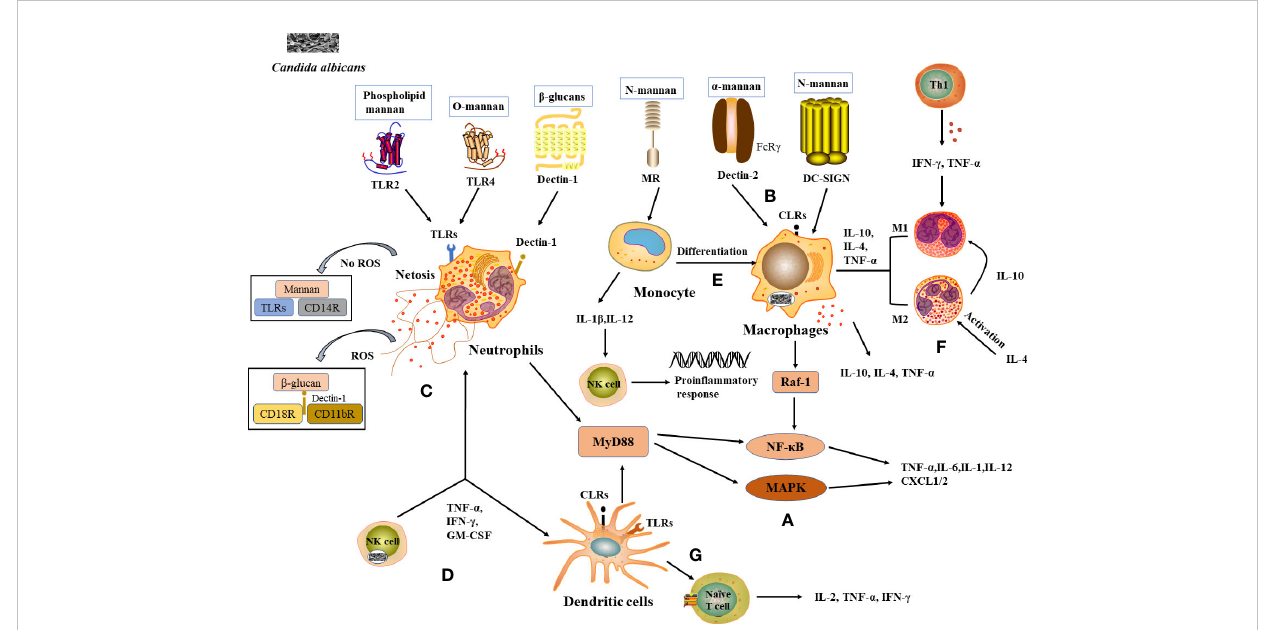
FIGURE 1 Recognition of C albicans cell wall components with PRRs and induction of immunocellular response. (A) TLRs and CLRs recognize with C albicans and activate immune cells to produce in fl ammatory factors. (B) PRRs on macrophages recognize (C) albicans cell wall components and activate corresponding signaling pathways and produces cytokines. (C) Neutrophils and NETs recognize signaling pathways produced by C albicans , thereby enhancing antimicrobial activity. (D) Cytokines released by NK cells enhance neutrophil activation and DCs maturation. (E) Monocytes differentiate into macrophages and the cytokines they produce activate NK cells to exert a stronger antimicrobial effect. (F) Role of differentiated macrophages M1 and M2 in the immune response. (G) DCs act as a bridge between innate and adaptive immunity, releasing cytokines involved in the immune